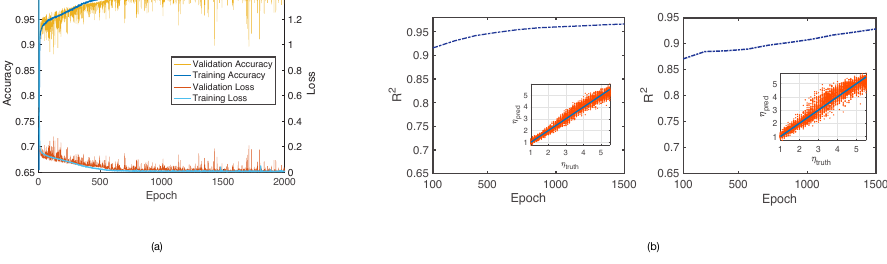
Figure 1. The architecture of the deep CNNs for recognizing the phase order and predicting the damp- ing coe ffi cient from the σ field configurations. Details of the network structure can be found in Ref. [13] Figure 2. (a) The accuracy and loss on training and validation data sets with di ff erent noise parameters B = 0.5, 1, 1.5, 2 and 2.5. (b) The training process in predicting the damping coe ffi cient from configu- rations. The left panel are prediction results for the crossover scenario, the right panel are prediction results for the first-order